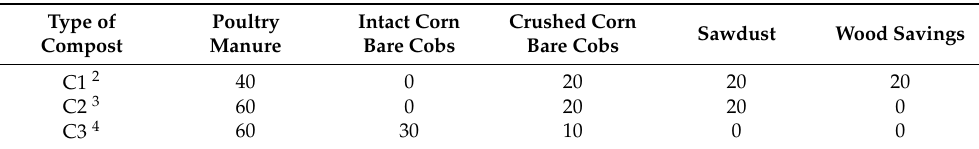
Table 1. Initial waste percentages (%) 1 used in each compost to formulate the substrates (S1, S2, and S3).